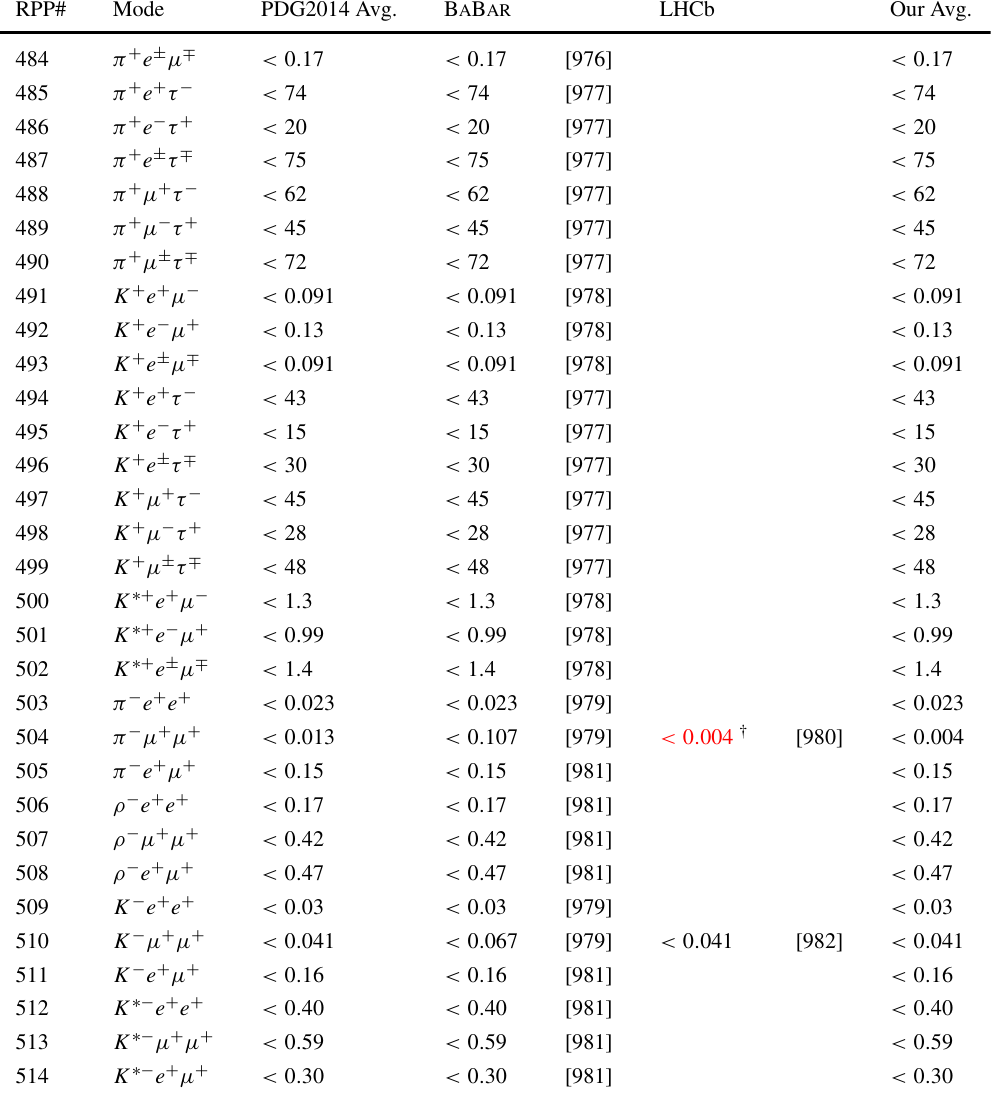
Table 235 Branching fractions of charmless semileptonic B + decays to LFV and LNV final states in units of × 10 − 6 . Upper limits are at 90% CL. Where values are shown in red (blue), this indicates that they are new published (preliminary) results since